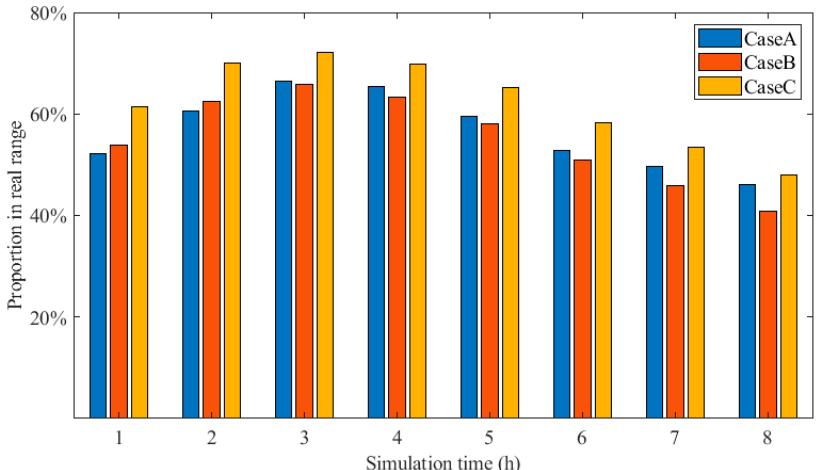
Figure 8. The proportion of simulated data in the real data range.